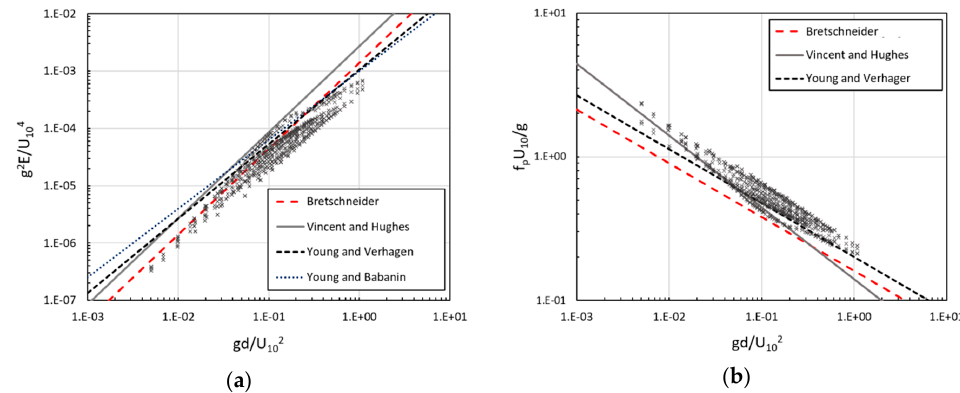
Figure 1. Scatter points numerically obtained with generation process in shallow depths in terms of dimensionless variables: ( a ) the wave energy, and ( b ) the peak frequency as functions of water depth. The lines represent the semi-empirical Equations (4) and (5) according to the authors listed in Table 1.